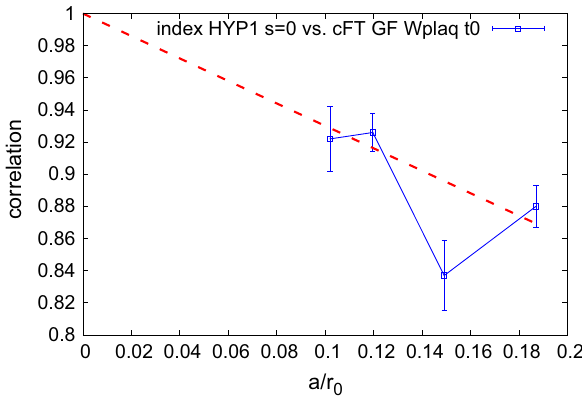
Fig. 11 Increase of correlation towards the continuum limit between one representative fermionic definition (index of the overlap operator evaluated on configurations with 1 step of HYP smearing applied) and one representative gluonic definition (with gradient flow, Wilson pla- quette smoothing action at flow time t 0 ). The dashed red line is a guide to the eye, showing that it is plausible that the correlation will become 1 in the continuum limit